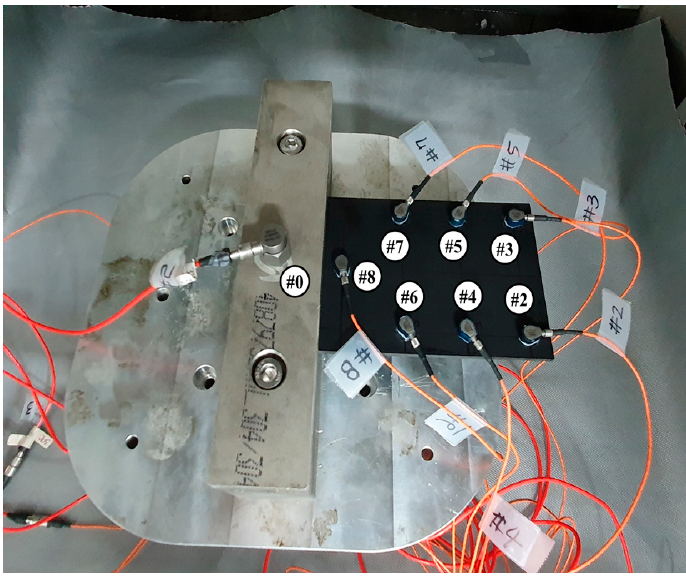
Figure 4. Location of accelerometers on the CFRP specimen (ch#2–ch8).